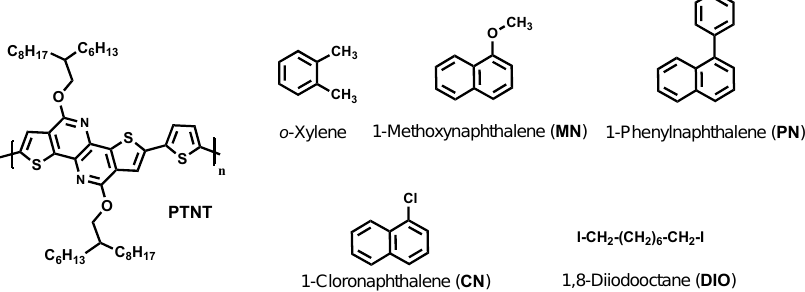
Figure 1. Chemical structures of poly (2,5-thiophene-alt-4,9-bis(2-hexyldecyl)-4,9-dihydrodithieno[3,2-c:3′,2′h][1,5] naphthyridine-5,10-dione (PTNT), o -xylene, and solvent additives used in the bulk heterojunction (BHJ) solar cell.